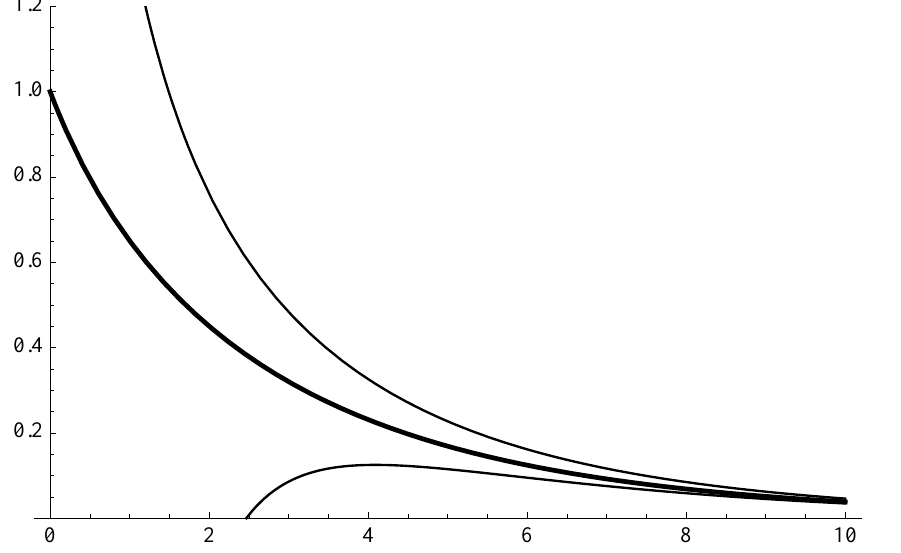
Figure 1. Graphs in [ 0,10 ] of the function a Vatta − np ( x ) (approximating φ ( x ) ) (16) (bold) and the tighter lower and upper bounds (12). Table 1. Maximum absolute relative errors ε r (10) of the different approximations of the function φ ( x ) and of its inverse, when it exists.